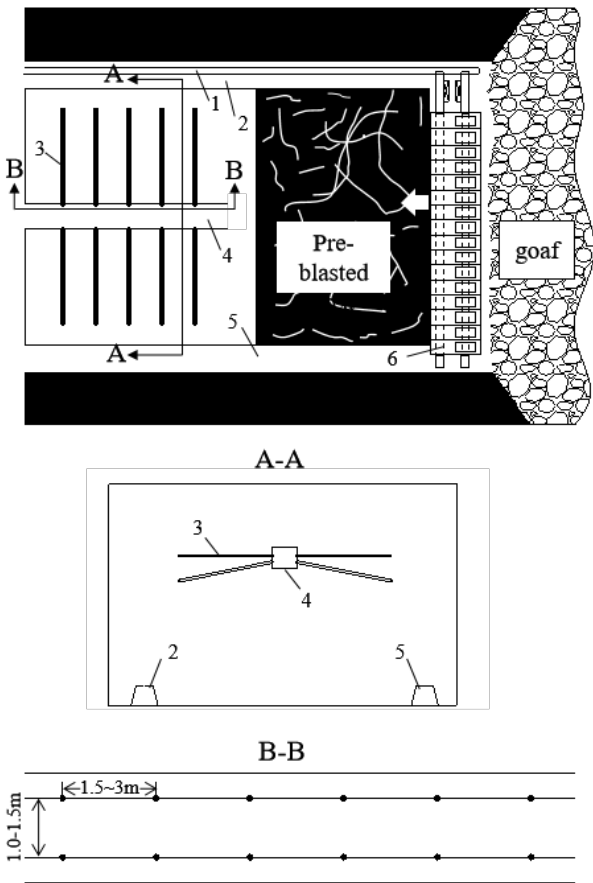
Figure 15. Top coal pre-splitting blasting.